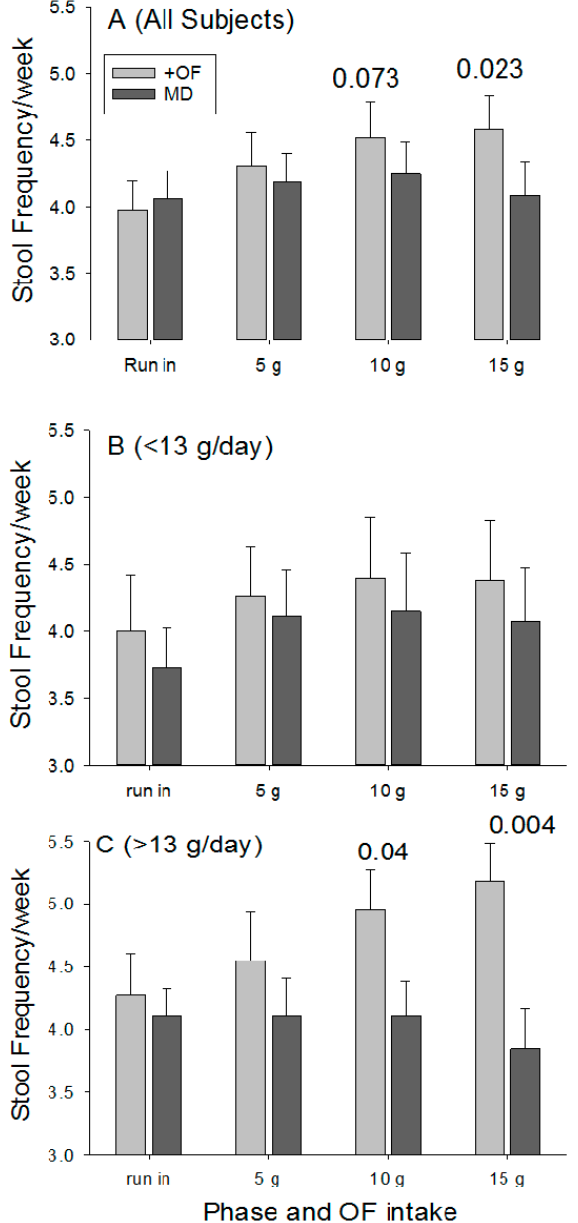
Figure 3. Stool frequency (number of bowel movements/week) of all study participants ( A ; +OF = 49; MD = 48) and differentiated by levels of habitual dietary fiber intake that were <13 g/day ( B ; +OF = 27; MD = 23) and >13 g/day, ( C ; +OF = 22; MD = 25). The p -values above the bars reflect differences with the baseline value during the run in phase. Bars without values are not different from baseline values. +OF group provided supplemental OF in addition to habitual dietary fiber intake. MD is the Placebo group.